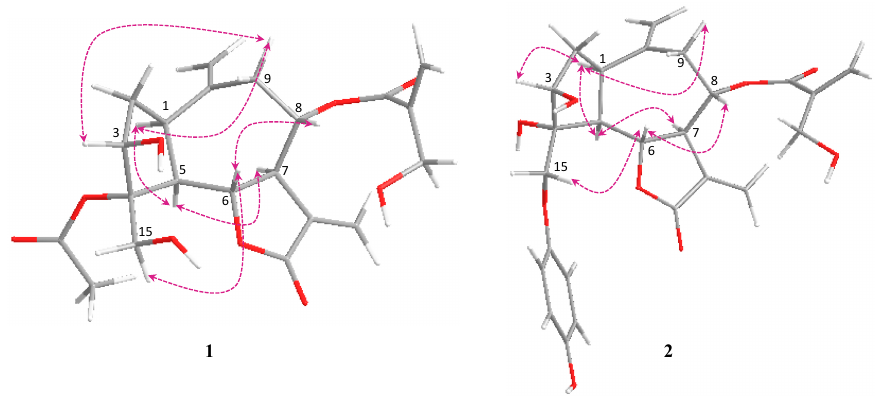
Figure 3. Significant NOESY correlations of 1 and 2.